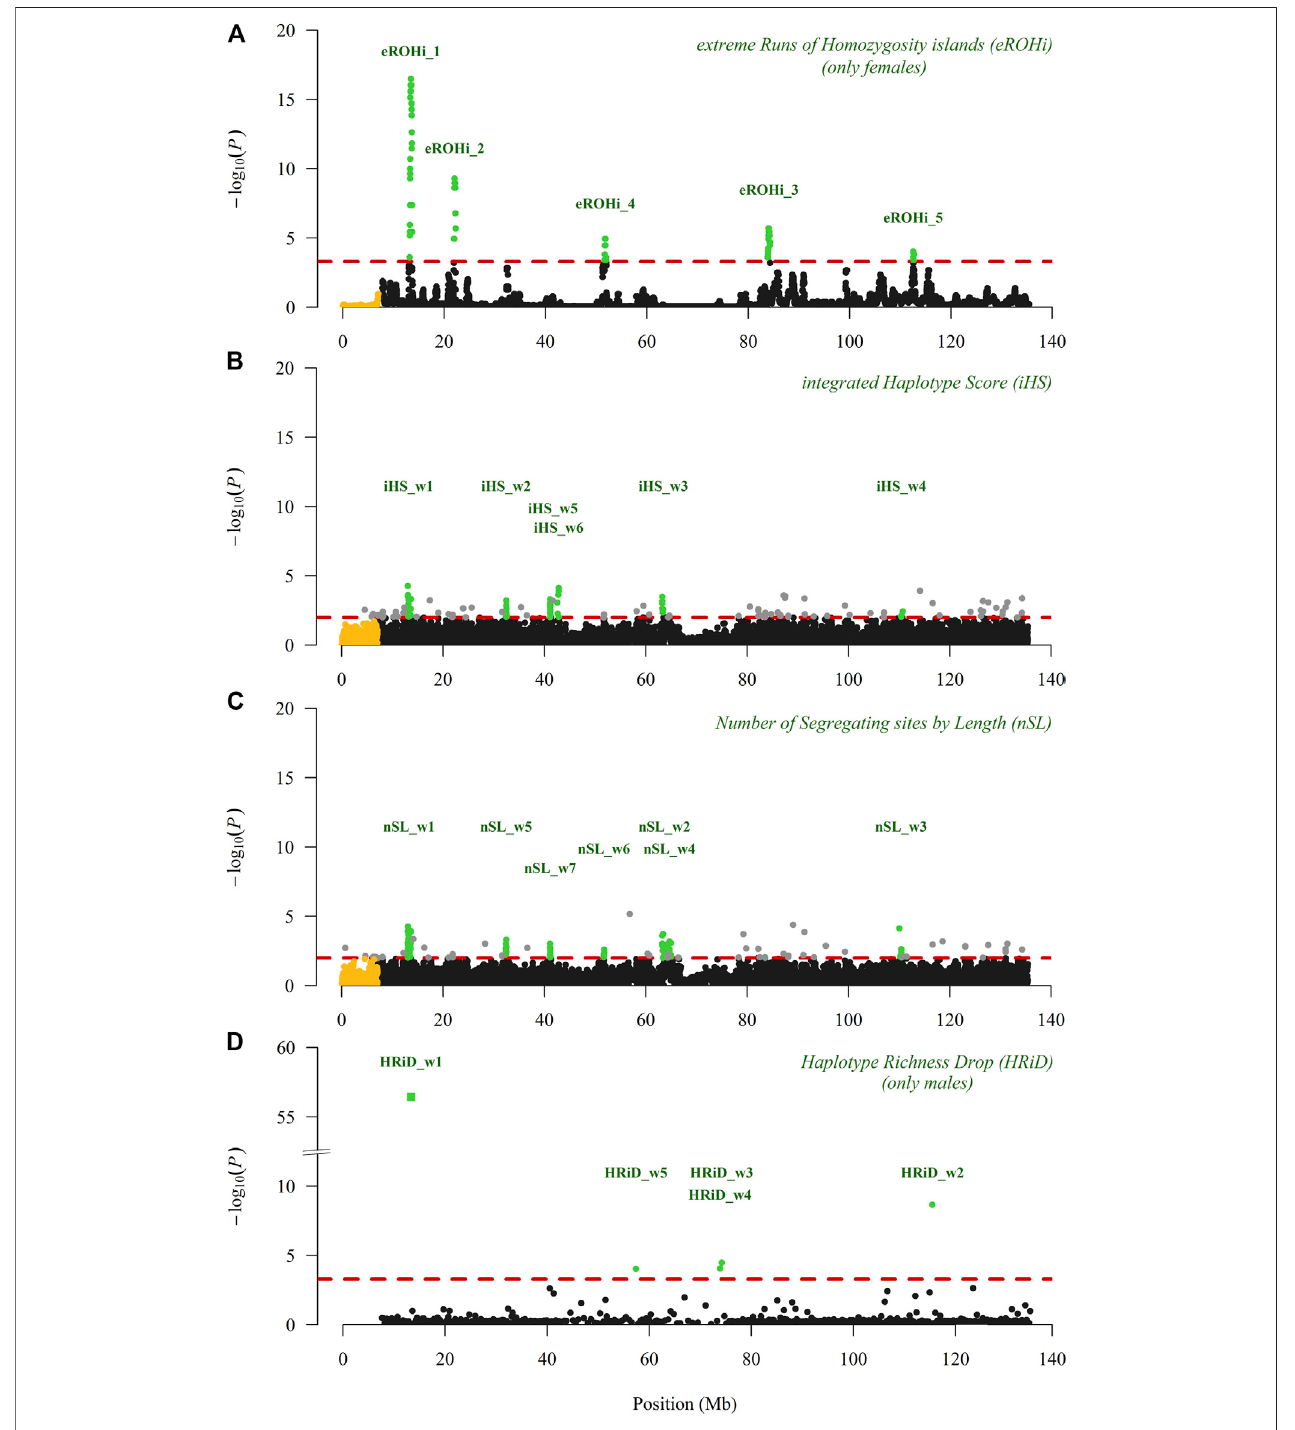
FIGURE2| VisualisationofpositiveselectionsignalsintheManhattanplotanalysedontheX-chromosome(pseudo-autosomalSNPsarecolouredinyellow)inEast Adriatic sheep using three “ classical ” (eROHi, iHS and nSL) and one new (HRiD) approach; (A) eROHi, (B) iHS, (C) nSL, and (D) HRiD. SNPs or windows above the dashed threshold line (in red) that were considered signi fi cant are coloured green, except for single SNP outliers (grey) observed in the iHS and nSL approaches.